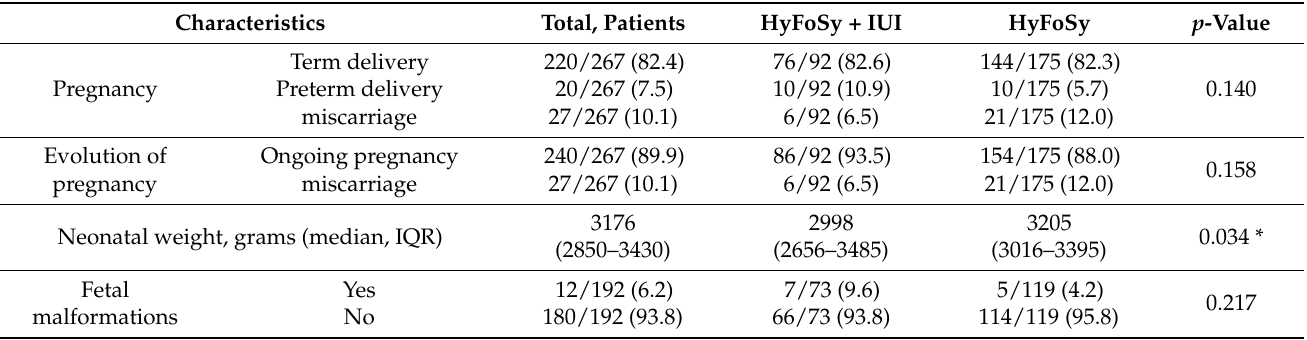
Table 4. Perinatal outcomes HyFoSy and subsequent intrauterine inseminations vs. HyFoSy